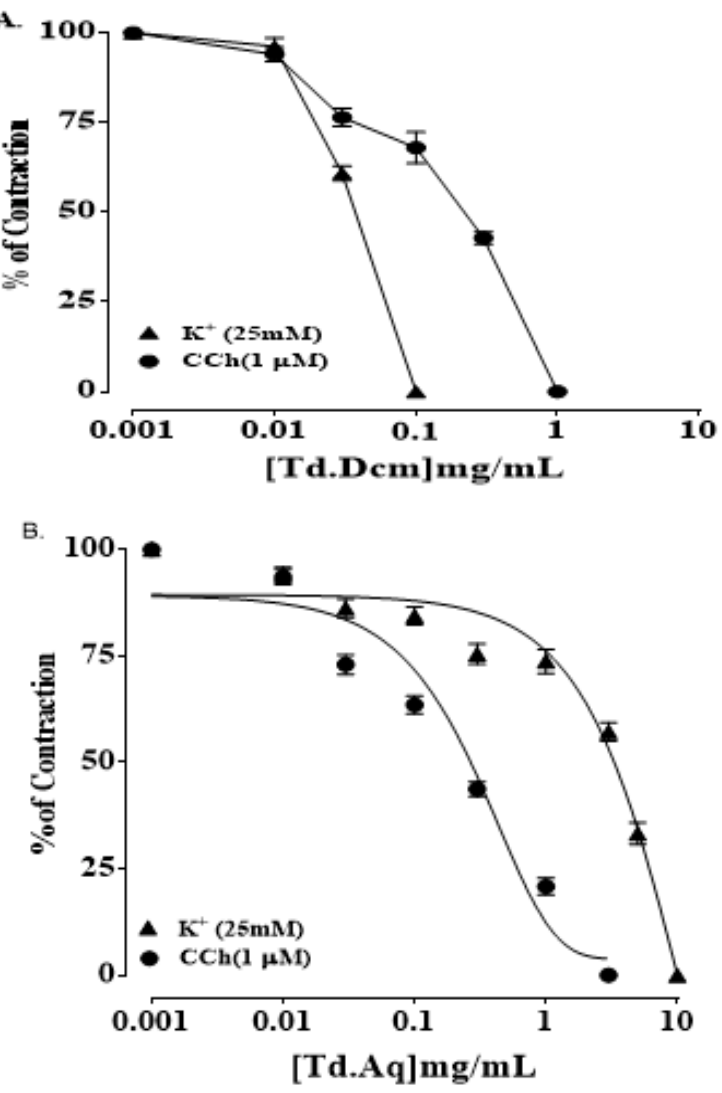
Figure 8. Concentration-response graphical presentation of ( A ) TdDcm and ( B ) TdAq on contractions provoked by CCh (1 µ mol / L) and K + (25 mmol / L) in isolated rabbit tracheal preparations. Values